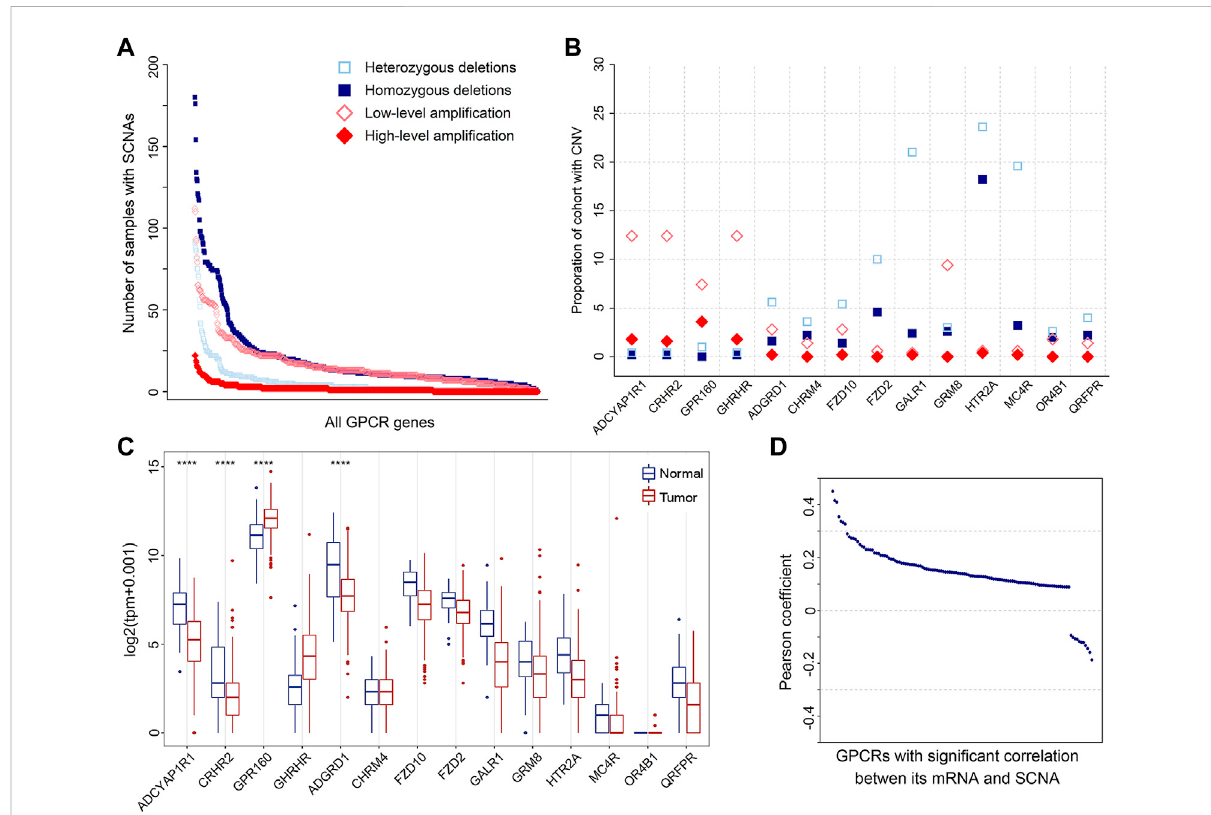
FIGURE 3 SCNAs of GPCRs in PRAD. (A) The number of heterozygous/homozygous deletions, and low-/high-level ampli fi cations for all GPCRs. (B) Scatterplotofrecurrentampli fi cationsanddeletionsin500primaryprostatetumorsamples. (C) Boxplotsshowingtheexpressionofthesigni fi cantly deleted and ampli fi ed GPCRs between the tumor and normal samples. (D) Distribution of Pearson ’ s correlation coef fi cients between the GPCR expression and its linear SCNA